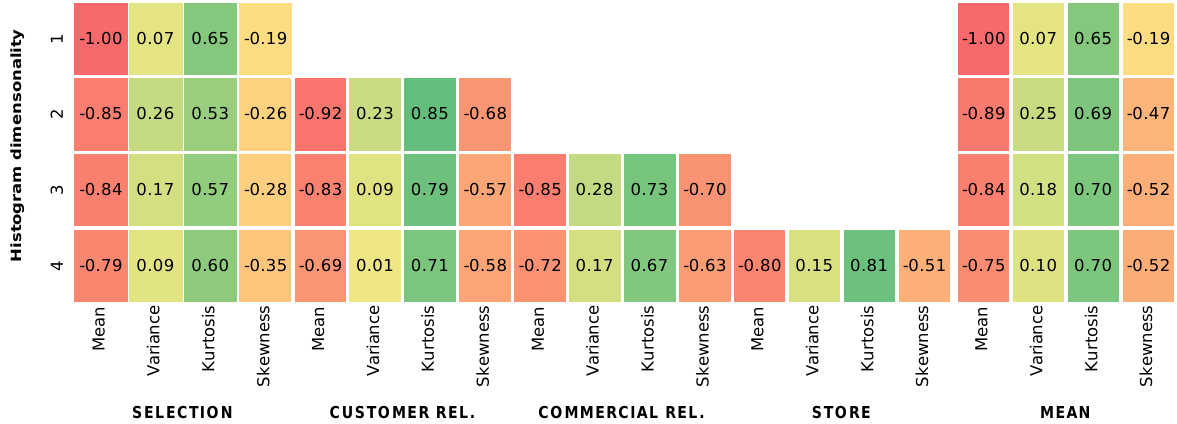
Figure 8. Pearson correlation between the distances of stores from the ideal and four statistics (mean, variance, kurtosis and skewness).